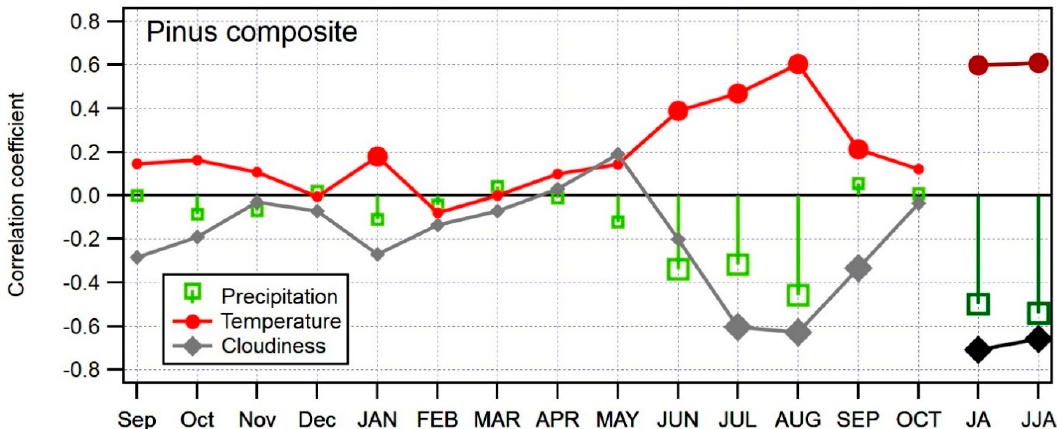
Figure 6. Bootstrapped correlation coefficients between average monthly meteorological variables (temperature, cloudiness, precipitation) and δ 13 C combined pine chronology for the period 1901–2013 (temperature and precipitation) and 1970–2013 (cloudiness). Significant correlations ( p < 0.05) are indicated with larger markers. Months of the year prior to ring formation are written in lowercase and months of the year of ring formation in uppercase. Seasonal variables are denoted JA (July to August) and JJA (June to August).